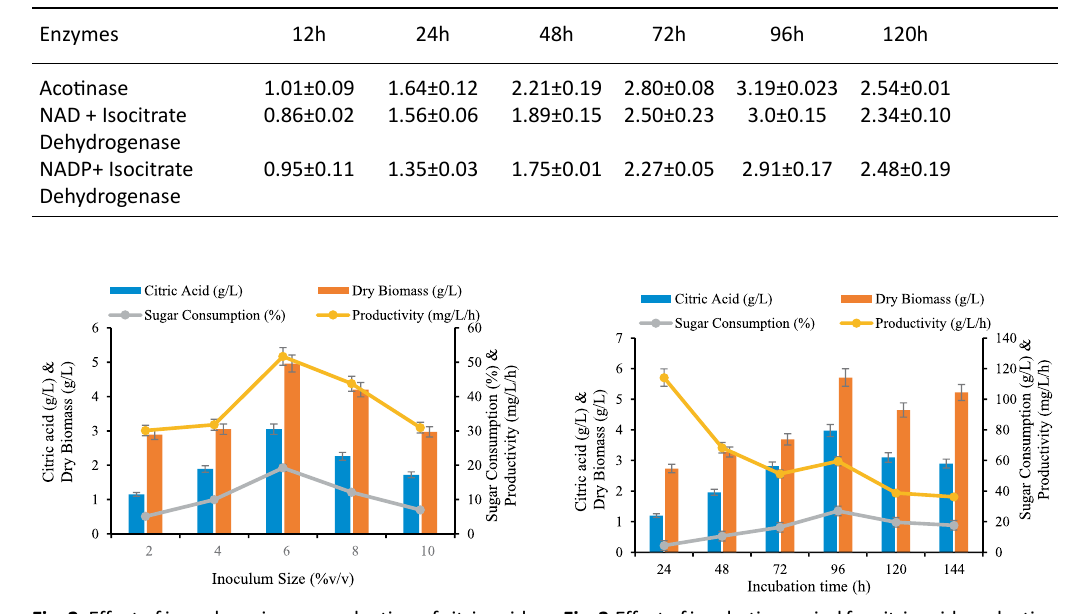
Fig. 2. Effect of inoculum size on production of citric acid Fig. 3. Effect of incubationperiod for citric acid